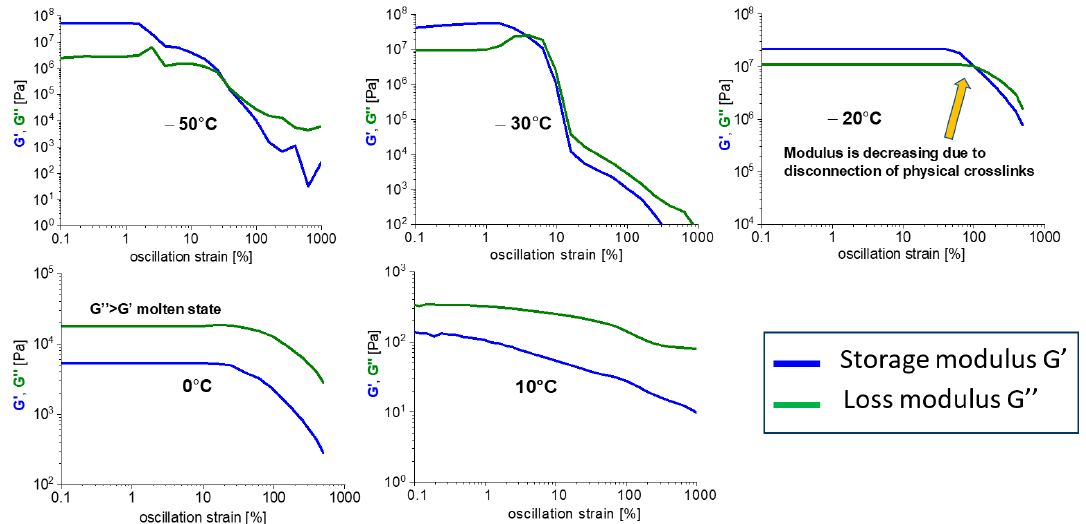
Figure5. DisconnectionofthephysicalcrosslinksinH11–BAFKU 2 bymechanicalstrain: strain-dependence of storage ( G (cid:48) ) and loss ( G ”) modulus of H11–BAFKU 2 at temperatures from − 50 to + 10 ◦ C—selected results; the full results collection is shown in Figure